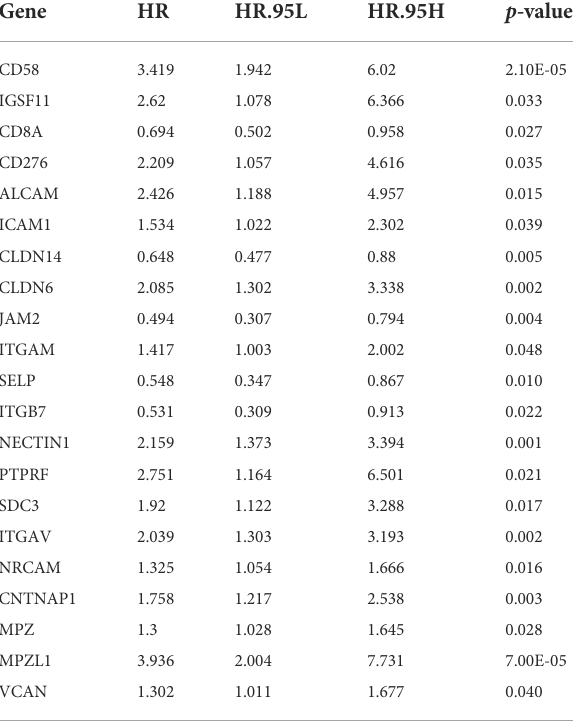
TABLE2 Theresults ofunivariate Coxanalysisgenerated byunivariate Cox analysis. Gene HR HR.95L HR.95H p -value